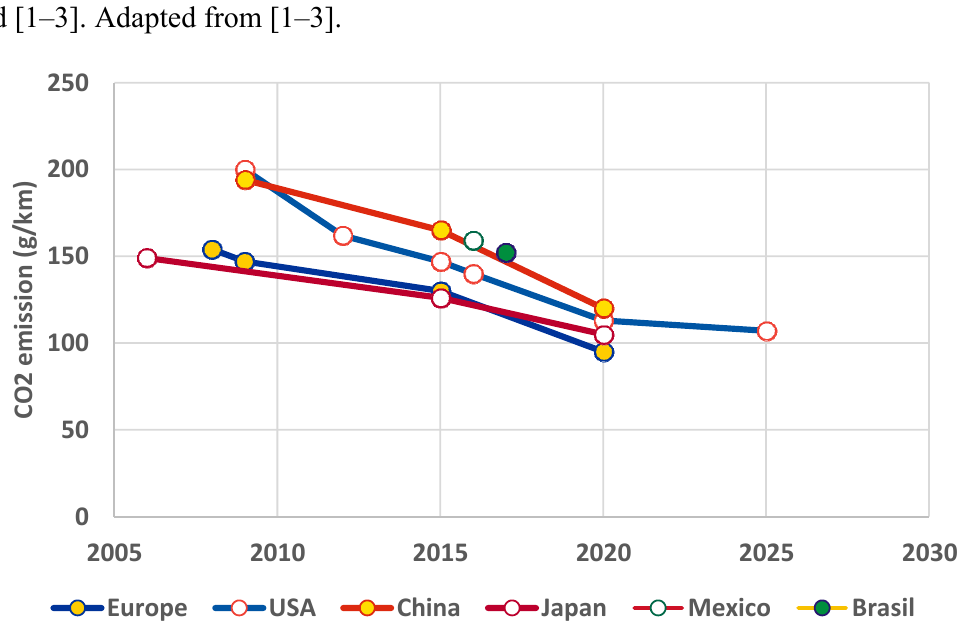
Figure 1. Carbon dioxide emissions regulations of different governments across the World [1 ‒ 3]. Adapted from